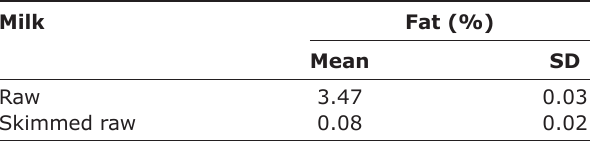
Table-3: Mean fat composition (±standard deviation) of raw and skimmed milk. Milk Fat (%)